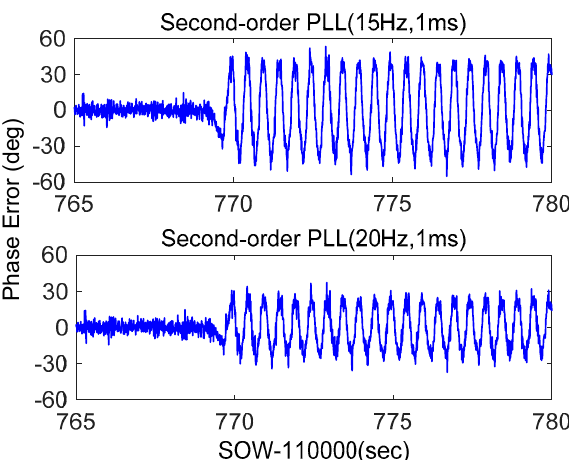
Figure 11. Phase error of stand-alone second-order PLL.